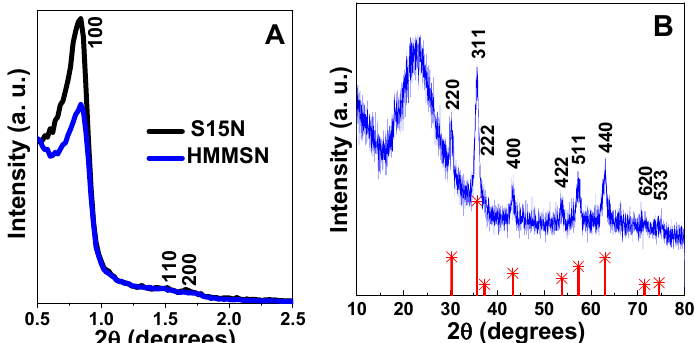
Figure 2. ( A ) Low-angle XRD patterns of the S15N mesoporous silica and HMMSN hybrid magnetic mesoporous nanorods and ( B ) the XRD pattern of HMMSN hybrid magnetic mesoporous nanorods (blue), with the theoretical XRD pattern of magnetite (red) for comparison purposes.